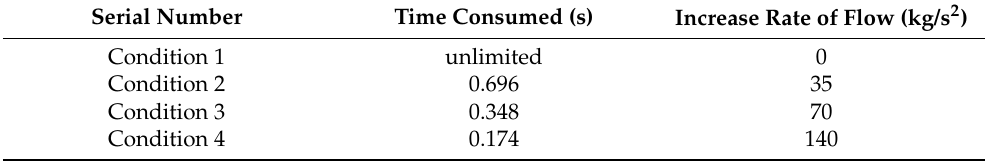
Table 3. Different working